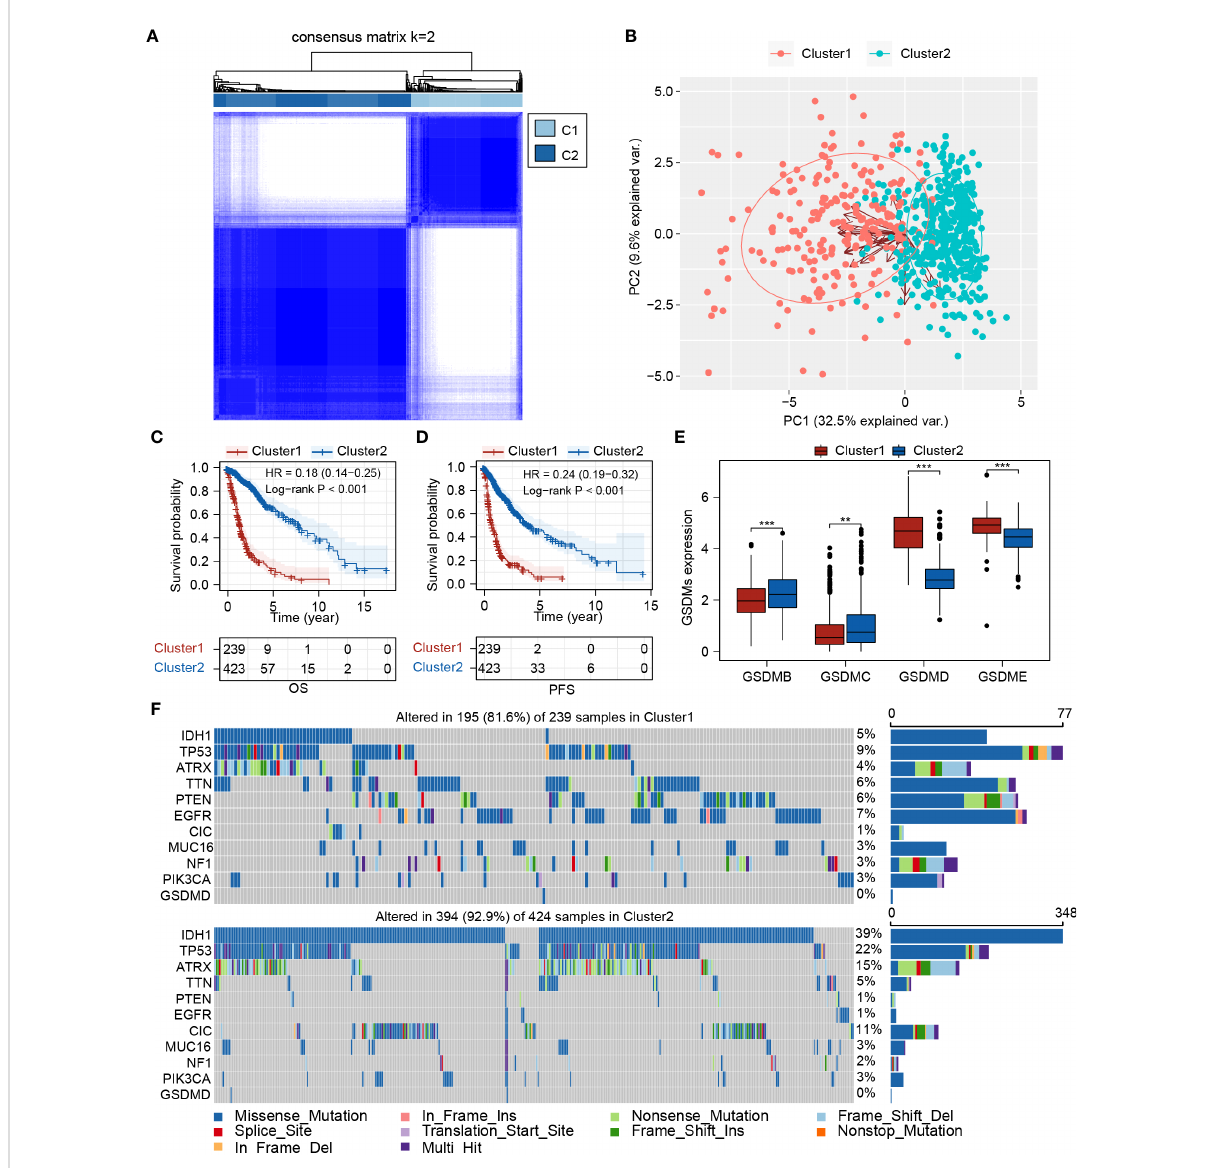
FIGURE 2 Expression pattern of pyroptosis-related genes could separate glioma patients into two clusters with distinct survival status. (A) Consensus clustering of TCGA-glioma cohort (n=662) based on pyroptosis-related genes. (B) PCA plot showed the separation between Cluster 1 and Cluster 2. (C, D) Survival analysis between Cluster 1 and Cluster 2 for OS and PFS, respectively. (E) Expression analysis of GSDMB , GSDMC , GSDMD , and GSDME in Cluster 1 and Cluster 2. (F) Mutation landscape analysis of Cluster 1 and Cluster 2. PCA, principal component analysis; IDH1, isocitrate dehydrogenase 1; TP53, tumor protein 53; ATRX, ATRX Chromatin Remodeler; TTN, titin; PTEN, phosphatase and tensin homolog; EGFR, epidermal growth factor receptor; CIC, capicua transcriptional repressor; MUC16, mucin 16, cell surface associate;